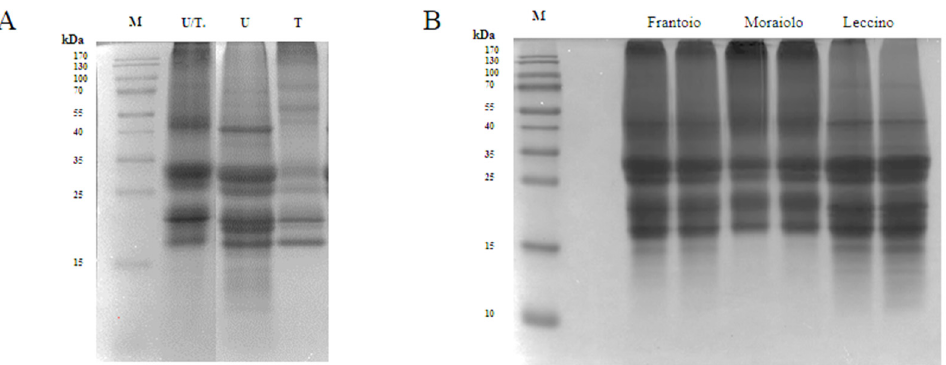
Figure 1. Proteins (50 µ g) were loaded in each lane, and protein size markers are indicated in kilodaltons (kDa). ( A ) SDS-PAGE of olive seed proteins extracted with different buffers U/T: UREA 6 M, 0.1 M Tris-HCl (pH 8), 0.5 M NaCl, 0.5% SDS, 0.1% DTT; U: UREA 8 M, 1% CHAPS, 0.1% DTT, T: 0.1 M Tris (pH 7.5), 0.5 M NaCl, 0.5% SDS, 0.1% DTT. ( B ) SDS-PAGE of different cul- tivars of olive seed proteins extracted with the final buffer. For each cultivar were performed two different